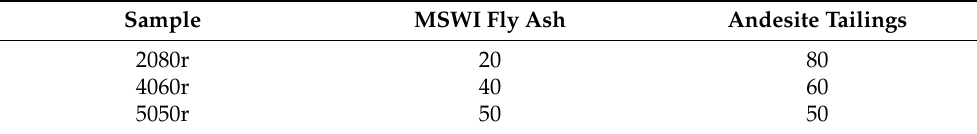
Table 2. Components of the glass–ceramic samples